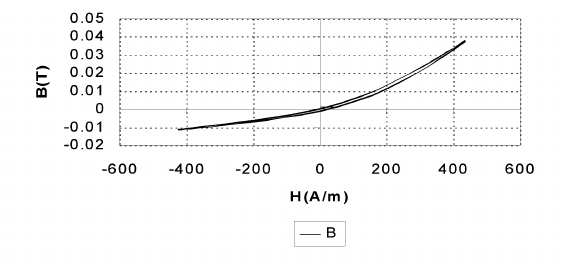
Figure 14: BH Curve for FCL under increased Line Voltage Conditions